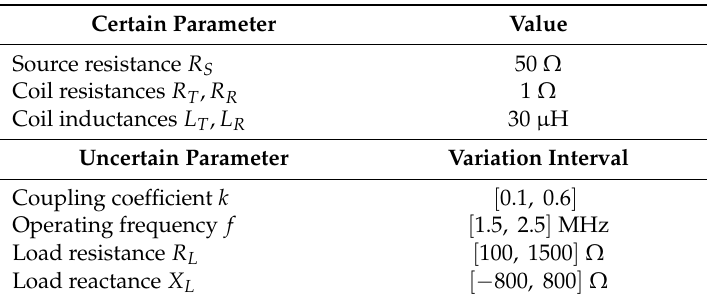
Table 4. Parameters of the modified WPT system.